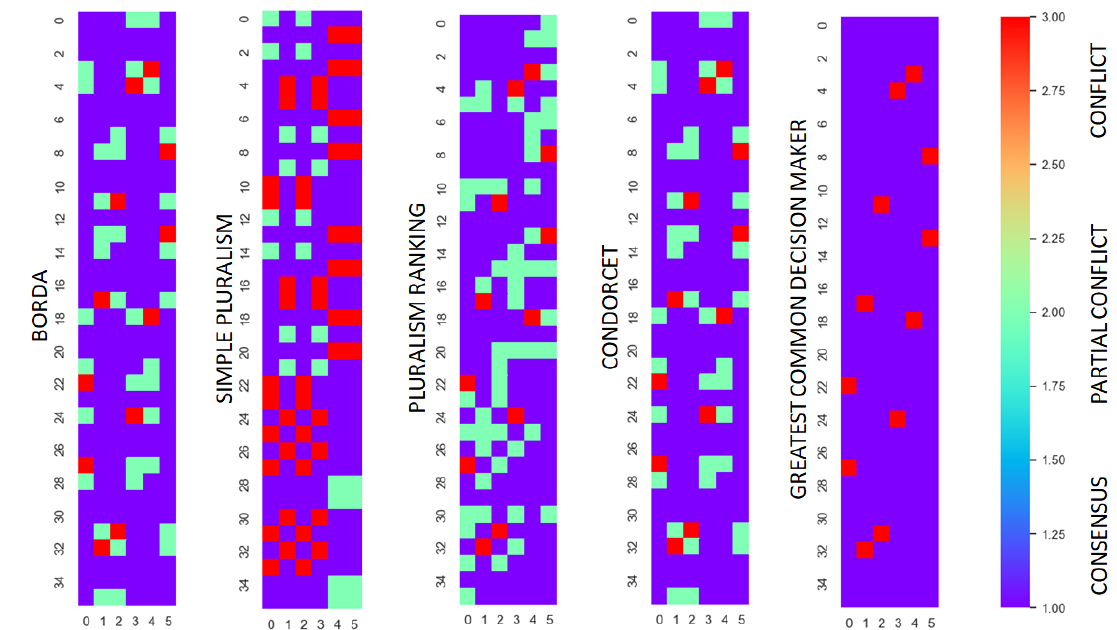
Figure 18. Comparison of all voting methods for 3 × 3 matrices.